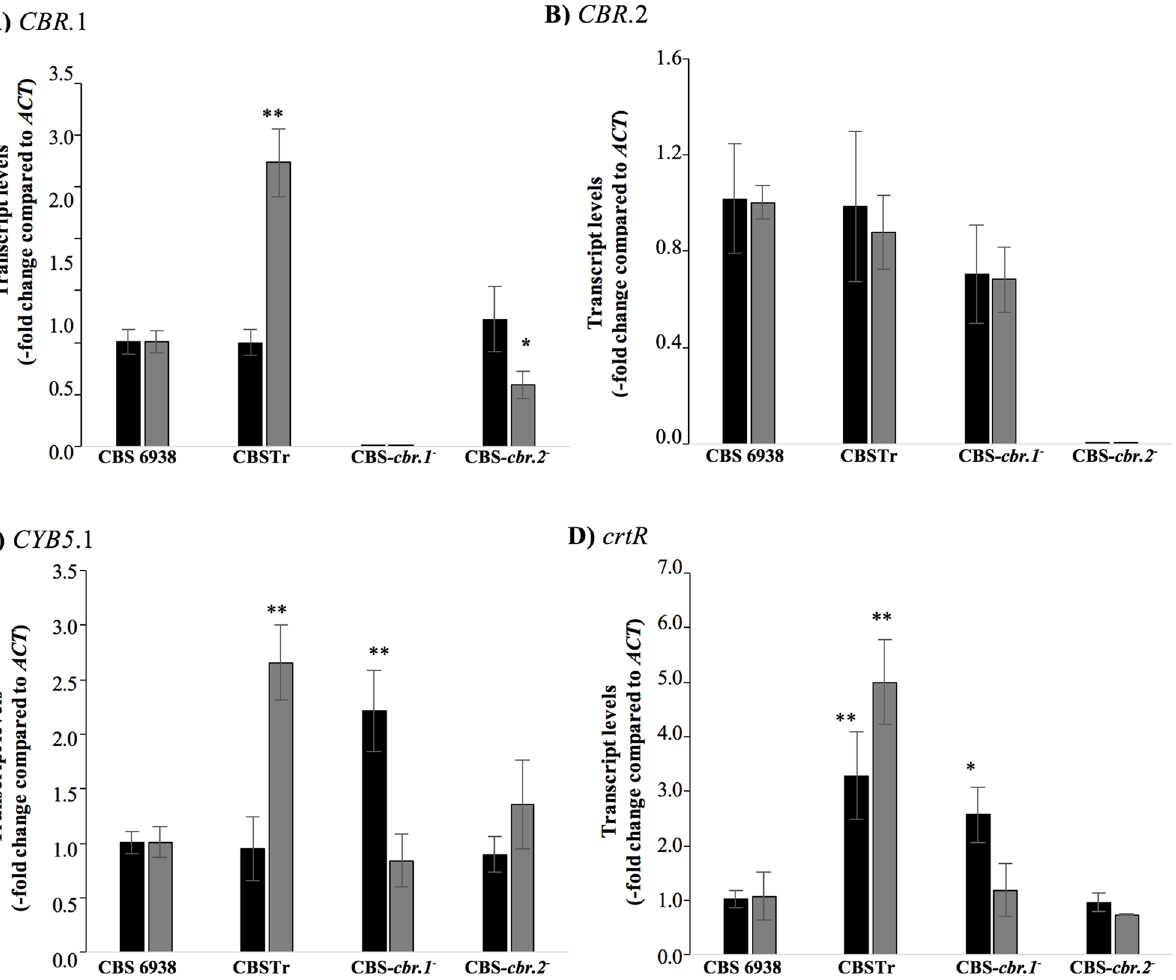
Fig 6. RT-qPCR for CBR .1. CBR .2, CYB5 and crtR transcript levels in the wild-type and mutant strains. (A) CBR .1 (B) CBR .2, (C) CYB5 and (D) crtR genes. The transcript level of each gene was normalized to actin mRNA. Black and grey bars represent the results using RNA extracted after 36 and 72 h of culture, respectively. Values are the mean ± standard deviation of two technical replicates from three independent cultures (Student ’ s t-test was performed to compare each mutant to the parental strain. * P < 0.05 and ** P <